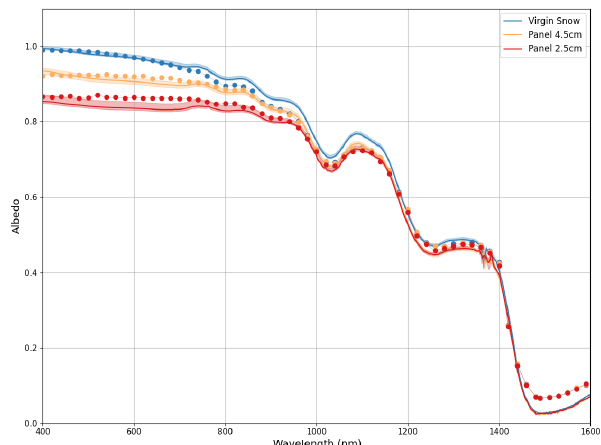
Figure 12. Simulated and observed spectral albedo for three dif- ferent snow depths. The solid lines indicate observations, and dot- ted lines indicate simulations. The shading around the observa- tions indicates the inter-quartile range of the measurements com- puted from the five snow and two reference scans collected during each measurement, providing an assessment of measurement un- certainty. The mean RMSE of the simulated albedo compared to measurement-derived albedo over 400–1600nm is equal to